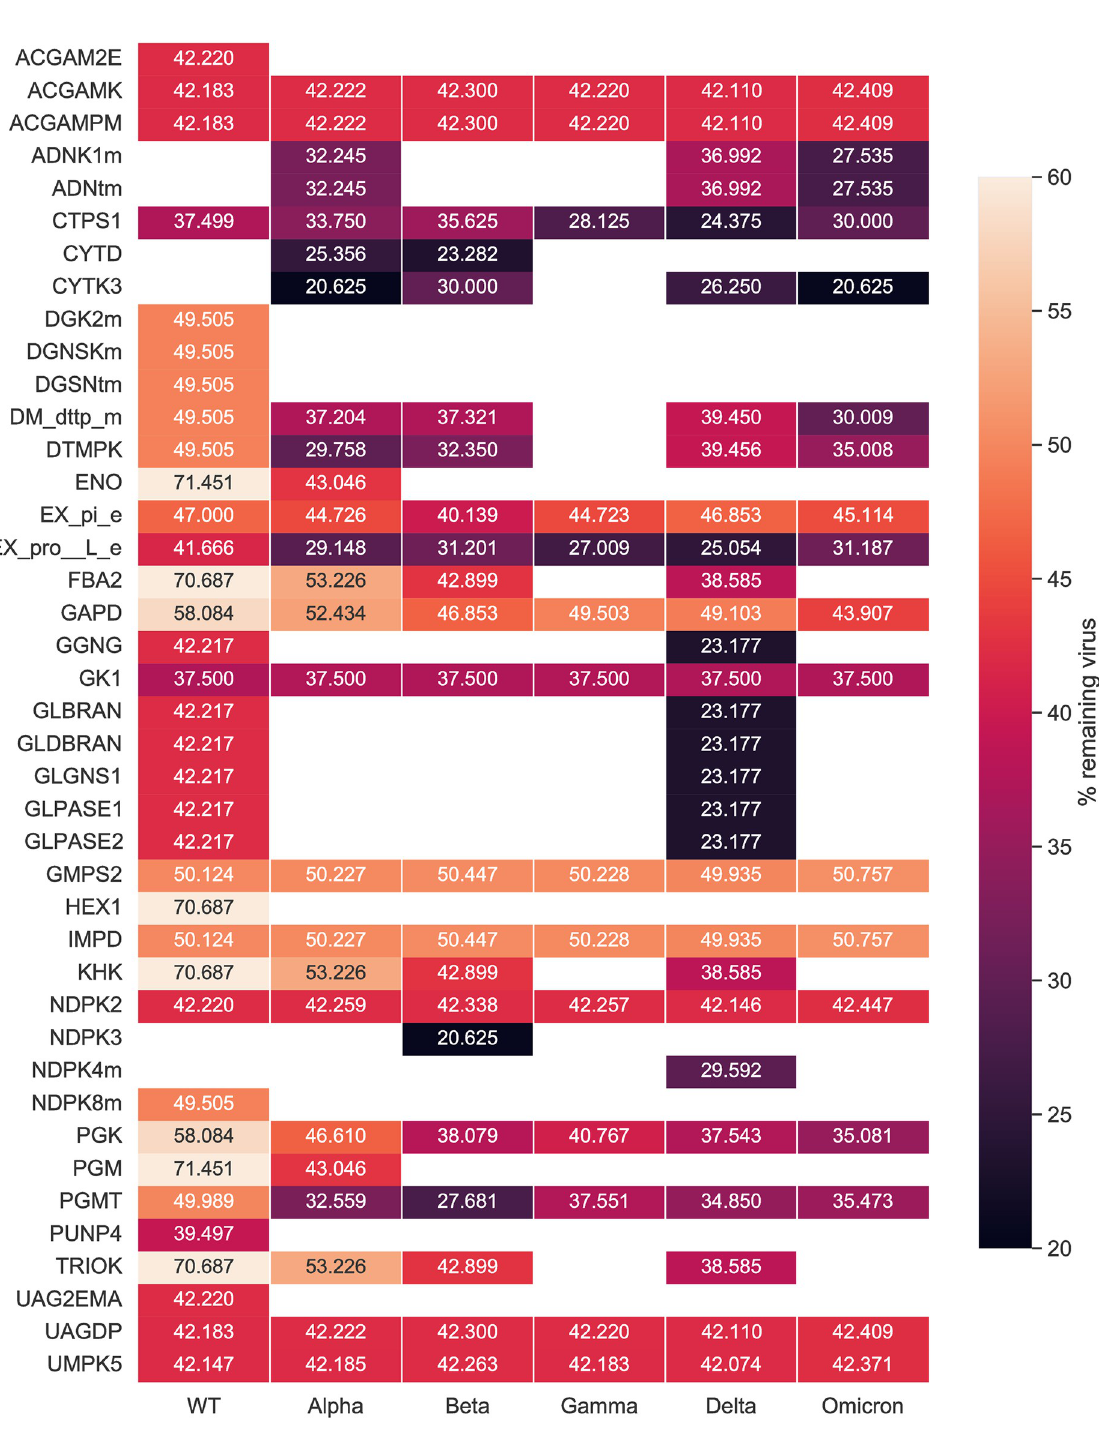
PLOS Computational Biology | https://doi.org/10.1371/journal.pcbi.1010903 March 23,